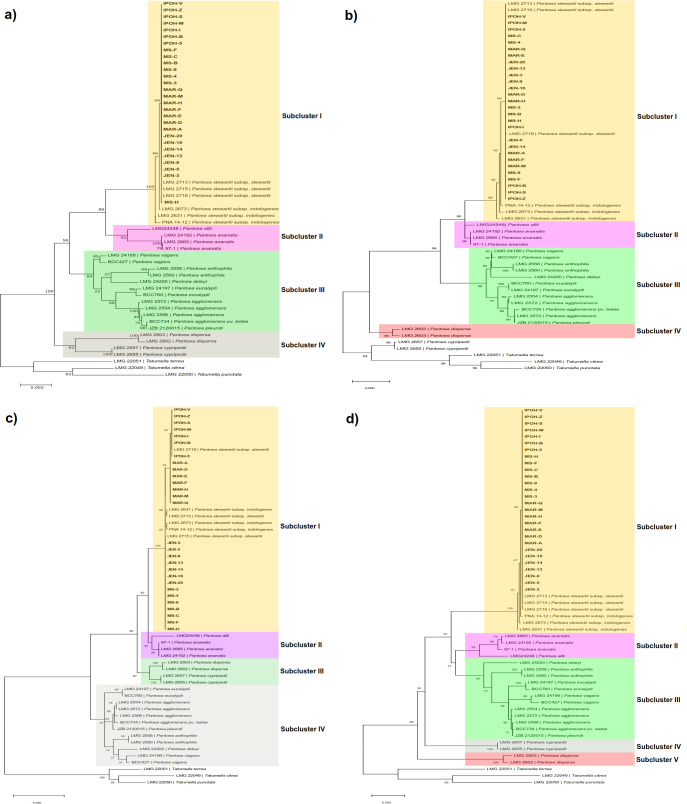
Maximum-likelihood tree based on the (a) gyrB; (b) rpoB; (c) atpD; and (d) infB genes. Percentage bootstrap values based on 1000 replicates are given at nodes. Tatumella species were included as an outgroup. Bar: 0.05 substitutions per nucleotide position.